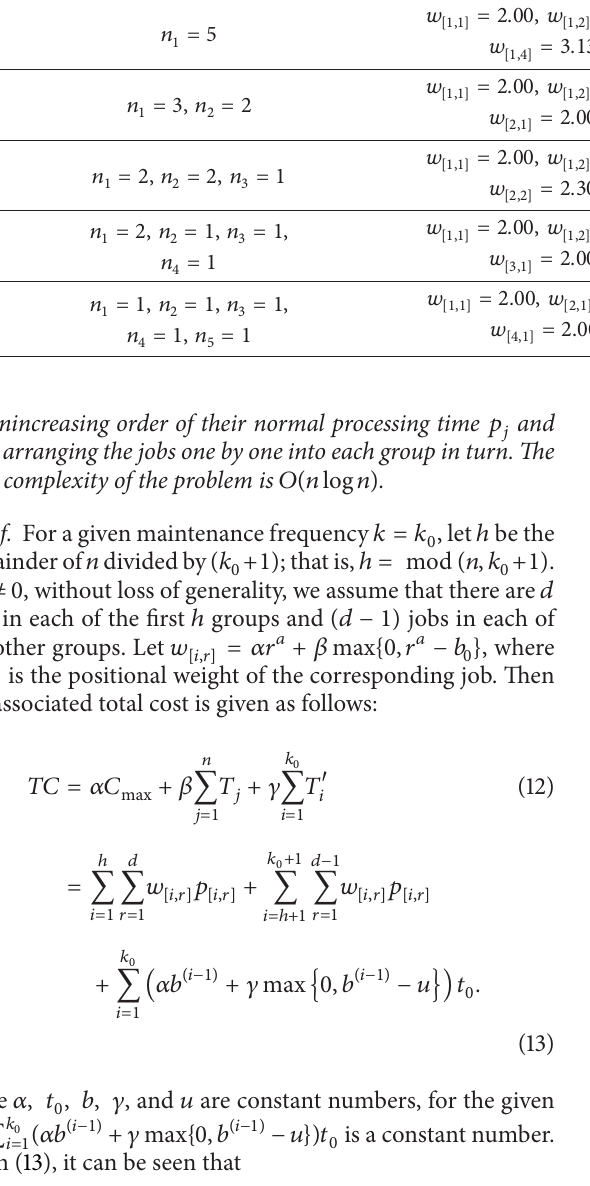
Table 1: The number of jobs in each group, the positional weights, the optimal schedule, and the total cost. 𝑘 The number of jobs in each group The positional weights The optimal schedule